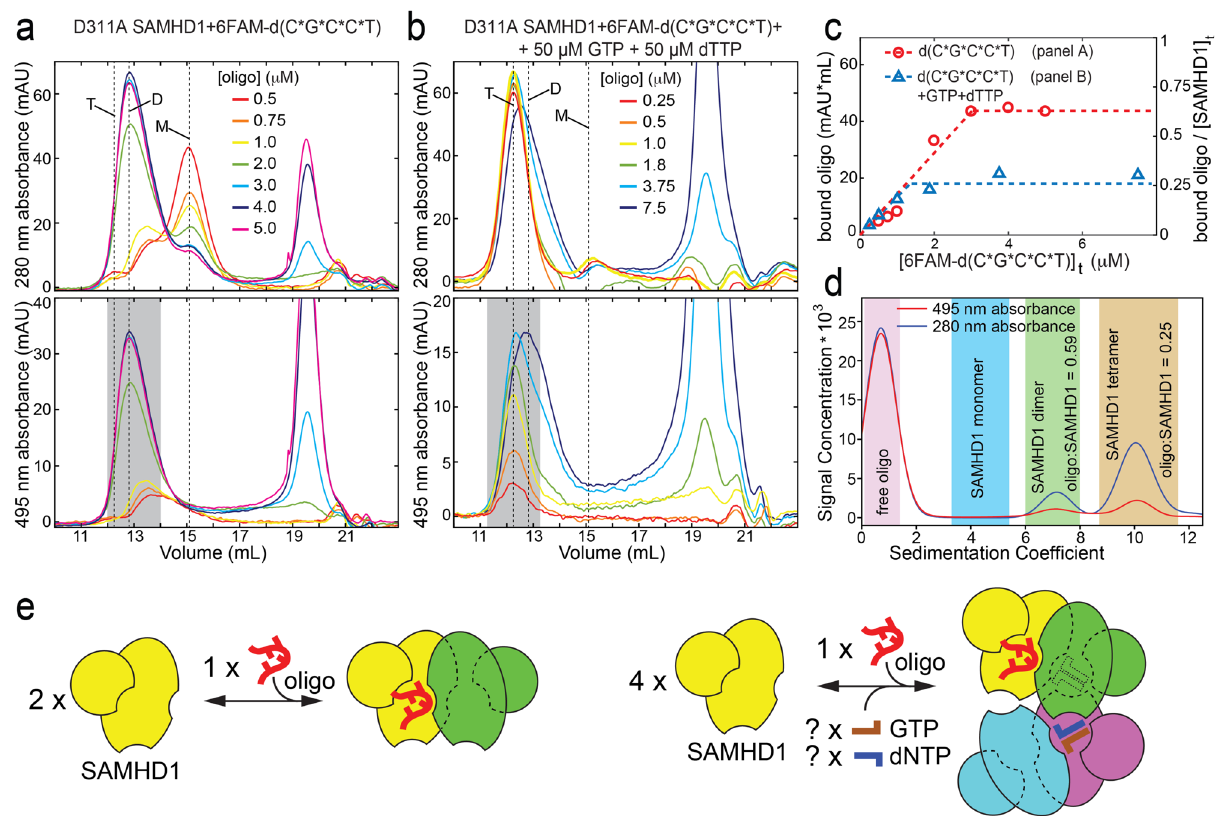
Fig. 4 Binding stoichiometry in SAMHD1:oligonucleotide complexes. a Size-exclusion chromatography (SEC) analysis of oligonucleotide:D311A SAMHD1 complexes formed with no GTP or dATP present. Absorbance measurements at two wavelengths, 280 and 495 nm, allow independent quanti fi cation of SAMHD1 and the oligonucleotide. The amount of oligonucleotide associated with the SAMHD1 dimer was determined by integrating the shaded area of the 495-nm chromatogram. The three dashed lines indicate the retention volumes of SAMHD1 monomer (M), dimer (D), and tetramer (T). b The same experiment as in ( a ) but performed in the presence of 50 μ M GTP and 50 μ M dATP in the running buffer and during incubation with the oligonucleotide. c Amounts of D311A SAMHD1-bound oligonucleotide, as determined by integrating the shaded areas of the 495-nm chromatograms in ( a , b ), plotted as a function of the total amount of the crude d(C*G*C*C*T) oligonucleotide added to SAMHD1. The left Y axis indicates absolute amounts and the right axis shows it as a fraction of the total amount of SAMHD1 (~5 μΜ ) used in the titrations. d Analytical ultracentrifugation analysis of the d(C*G*C*C*T):D311A SAMHD1 complexes formed in the presence of GTP and dATP using 280- and 495-nm multiwavelength detection. Quanti fi cation of SAMHD1 and the oligonucleotide present in distinct complexes was performed by integrating the shaded areas of the plot. e Asymmetric oligonucleotide:SAMHD1 complexes formed as a result of the allosteric communication between distinct SAMHD1 monomers in the